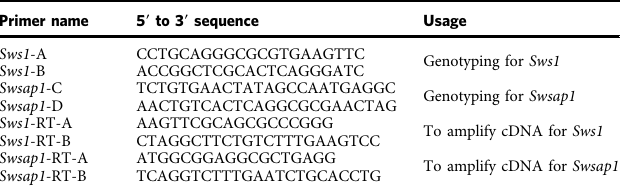
Fig. 4 Chk2 mutation rescues fertility of Sws1 and Swsap1 mutant females. a Ovary to body weight ratios of Sws1 − / − Chk2 − / − and Swsap1 − / − Chk2 − / − adult mice are similar to controls, but testis to body weight ratios remain signi fi cantly reduced. Female mice: Control, n = 16; Chk2 − / − , n = 7; Sws1 − / − , n = 5; Sws1 − / − Chk2 − / − , n = 3; Swsap1 − / − , Swsap1 − / − Chk2 − / − , n = 3. Male mice: control, n = 15; Chk2 − / − , n = 14; Sws1 − / − , n = 4; Sws1 − / − Chk2 − / − , n =